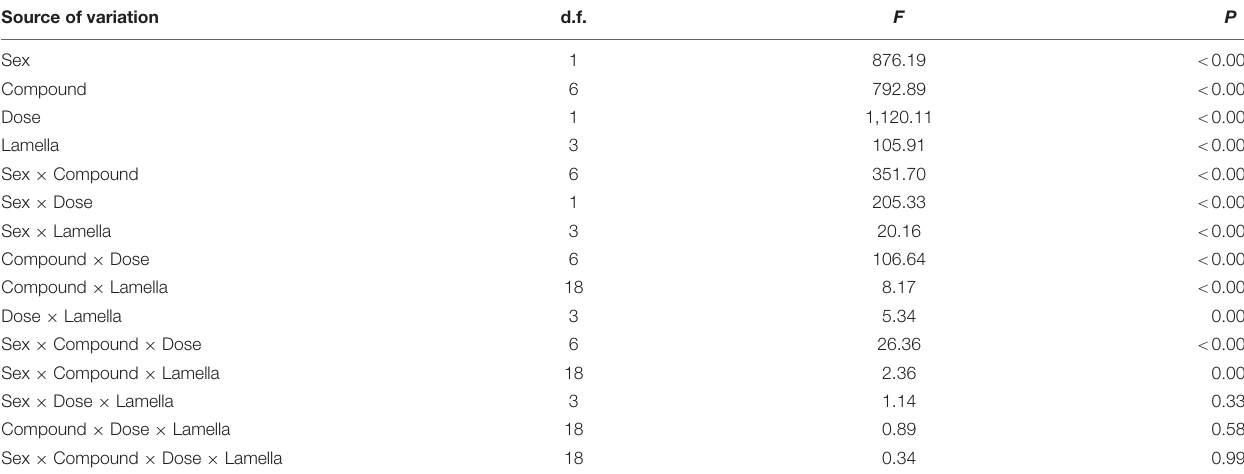
FIGURE 2 | Simultaneous EAG recordings from three lamellae of one antennal club and the closed club of the second antenna in response to anisole (A) and 1-hexanol (B) . The amplitudes in each small window were instantaneous reads recorded by a customized probe. The windows 1, 2, 3, and 4 display EAG traces captured by the recording electrodes 1, 2, 3, and 4 in Figure 1 , respectively. TABLE 1 | The effects of sex, compound, dose, lamella, and interactions of these variables on absolute EAG responses. Source of